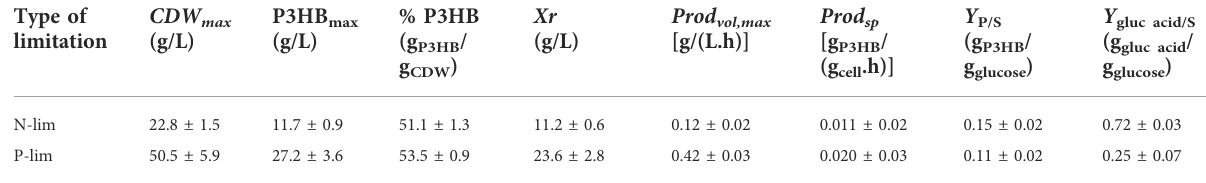
TABLE 2 Summary of the results obtained for H. boliviensis fed-batch cultivations in a bioreactor using P-lim and N-lim strategies toward P3HB production.MaximumP3HBtitersattained,correspondingresidualbiomass( Xr ),maximumoverallvolumetricP3HBproductivity( Prod vol,max